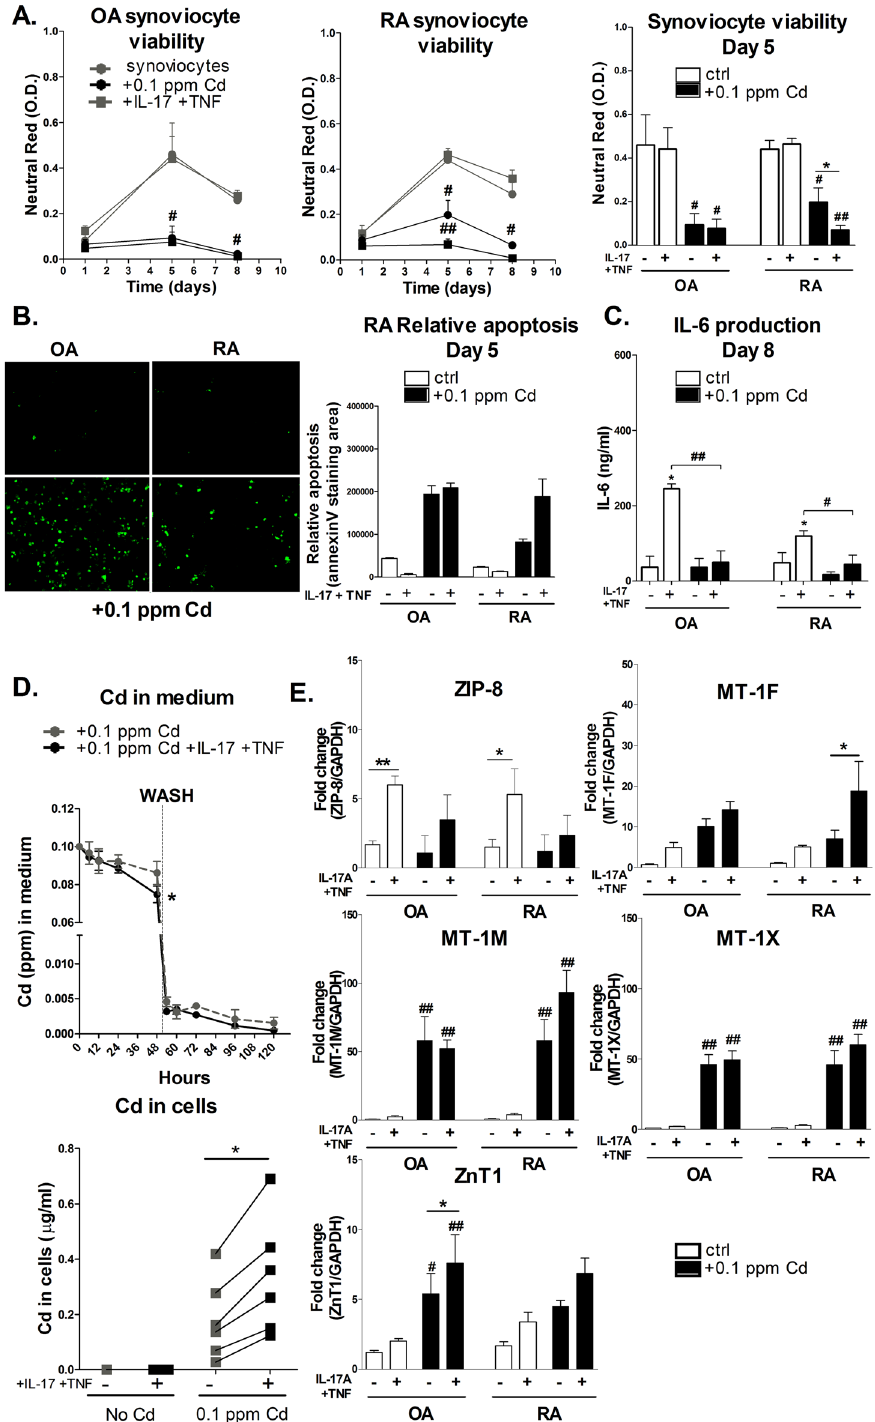
Figure 1. Inflammation drives ZIP-8 and MT-s mediated Cd absorption and accumulation in synoviocytes, inducing apoptosis and reducing IL-6 production. ( A ) Cell viability of OA and RA synoviocyte cultures assessed by neutral red assay at day 1, 5 and 8 after exposure to Cd. ( B ) Annexin V staining of OA and RA synoviocytes exposed or not to Cd for 5 days in the presence or not of IL-17 and TNF. ( C ) IL-6 production of OA and RA synoviocyte cultures assessed by ELISA assay at day 8 after exposure to Cd. ( D ) Cd concentration in medium as function of time and in synoviocyte culture at 120 hours. Gray dashed line: control experiment with no cytokine addition. Black line: Cd plus IL-17 and TNF condition. Vertical dashed line at 48 hours: washing. ( E ) Gene expression of Cd transporters in comparison to GAPDH. Black bars and lines: exposure to Cd. Data are the mean of at least three independent cell lines/biopsies (from three independent patients). Data are represented as mean ± SEM; * shows differences between non-inflammatory and inflammatory conditions, # shows differences due to Cd addition; * /# p < 0.05, ** /## p <